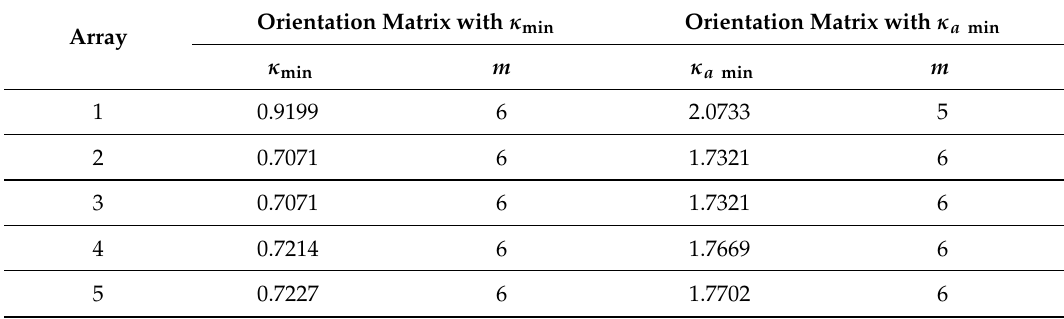
Table 2. Minimum values of interference coefficient κ and average interference coefficient κ a for the orientation matrices formed by m sensor